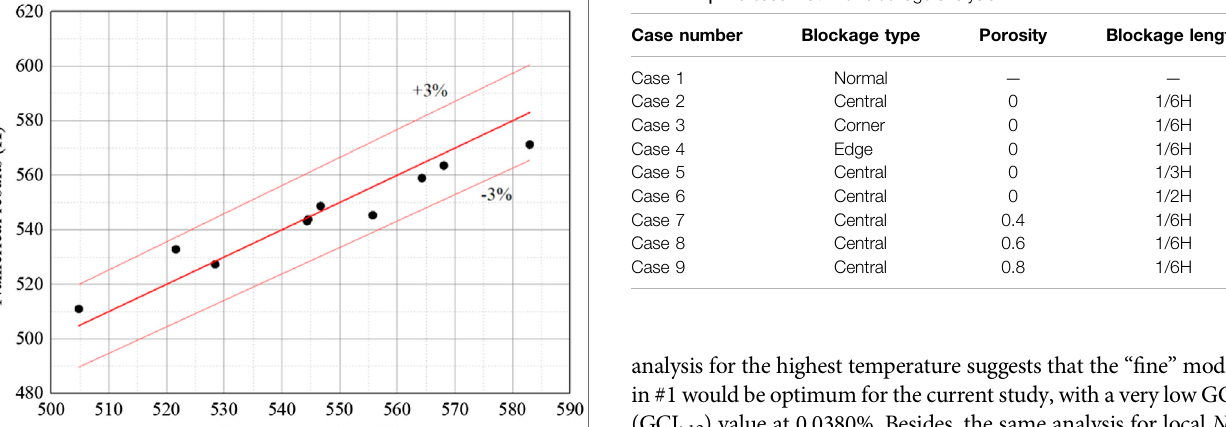
TABLE 4 | The case matrix of blockage